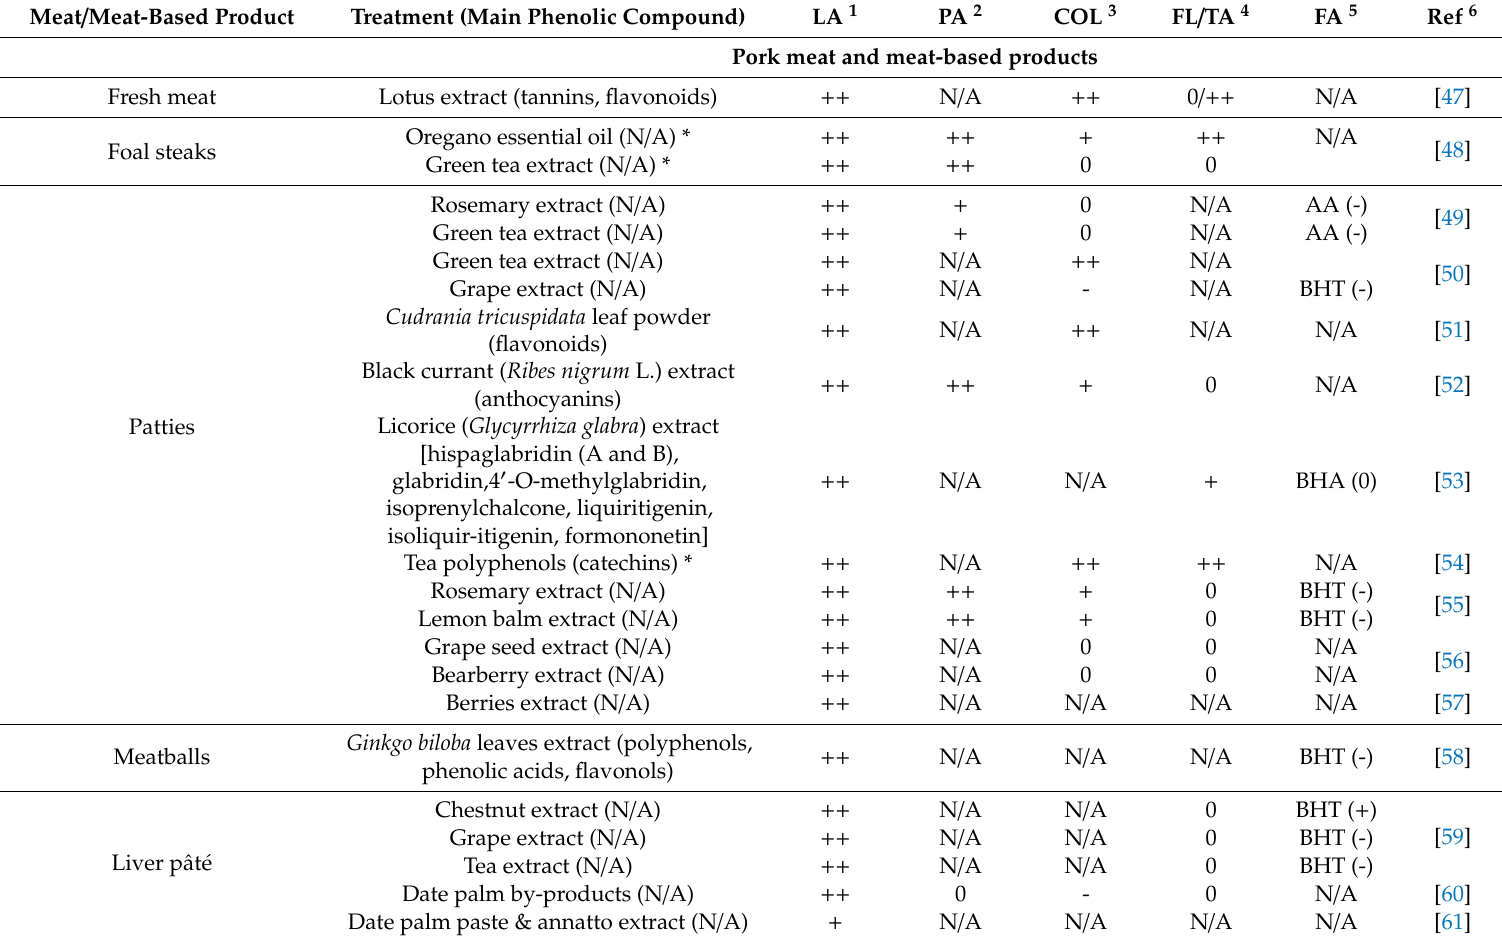
Table 1. Antioxidant e ff ect of phenolic compounds in meat and meat-based products. Meat / Meat-Based